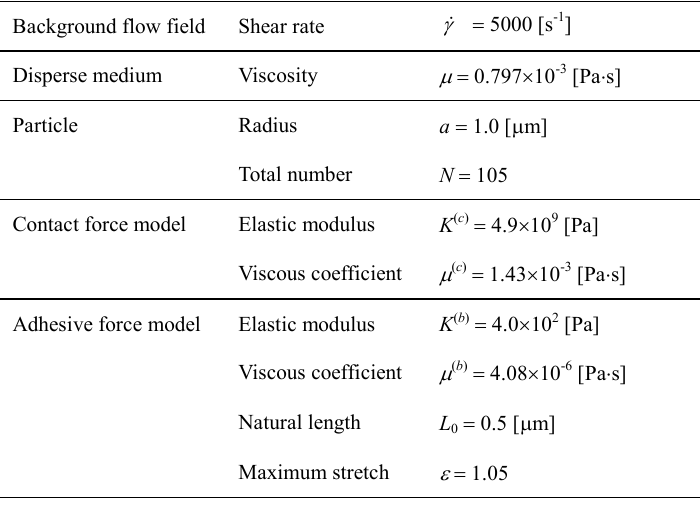
Table 1 Parameters used for the background flow field, the disperse medium, the particle, the contact force model, and the adhesive force